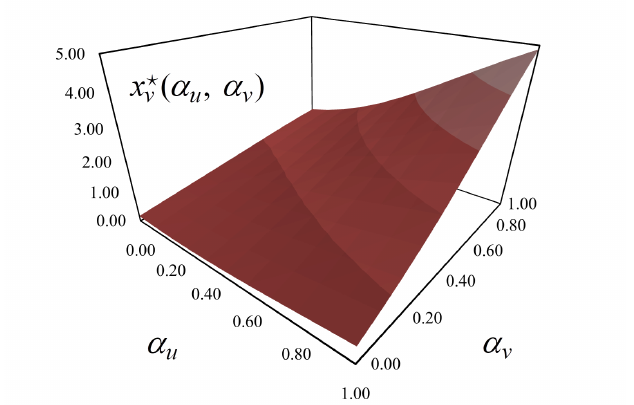
Figure 5. Nash bargaining solution ( x (cid:63) v ) with divergent expectations. The left-sided x -axis corre- sponds to the decay parameter of u ( α u ). The right-sided y -axis is the decay parameter of v ( α v ). The z -axis denotes Nash allocations ( x (cid:63) v ( α u , α v ) ).